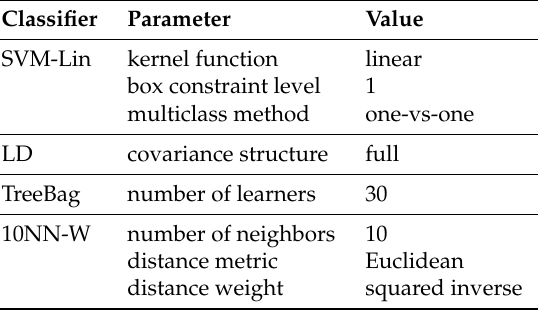
Table 1. The parameters of the tested